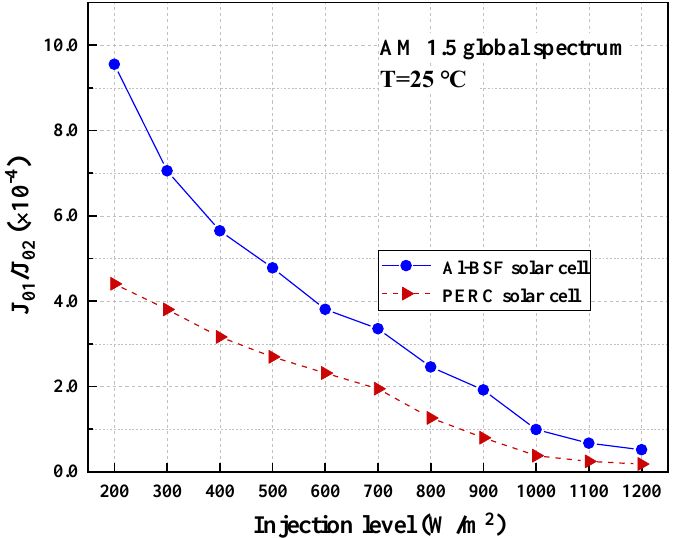
Figure 7. Variation in J 01 / J 02 of an Al-BSF solar cell and a PERC solar cell as a function of injection level at 25 °C and AM1.5G.